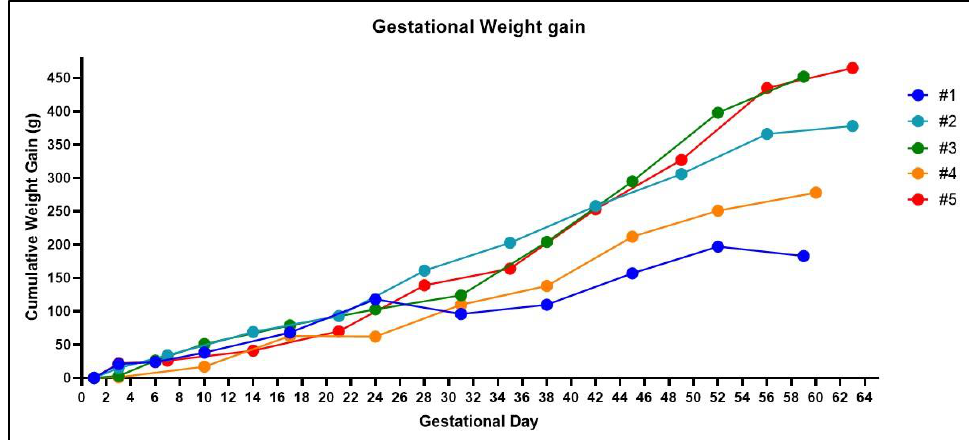
Figure 3. Weight changes in the guinea pig throughout gestation. Noticeable increases in gestational weight are not reliable until mid-pregnancy in the guinea pig. Healthy fetuses were confirmed in all the animals at gestational day 30 using an ultrasound, except for one animal (#1) in which blood in the vaginal lumen was observed at gestational day 24 and was associated with a decrease in cumulative weight gain. At post mortem, #3 had four fetuses, #5 had three fetuses, #2 and #4 had two fetuses, and #1 was not pregnant.